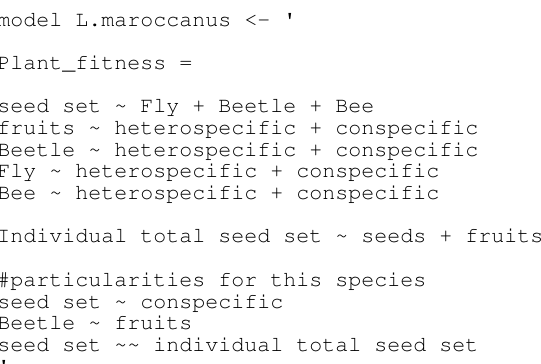
Figure 4. SEM of P. paludosa . As the ANOVA results and the AIC test suggest for this species, the unconstrained model fits the data better, and hence the scale is not considered. The lines (dashed and solid lines) are proportional to the magnitude of the relationships (we plot the standardized total effects) to exemplify the path. The numbers included on the paths are the standardized total effects, which remain the same across scales. The dashed lines represent negative relationships. It is important to mention that the correla- tions between the variables are not visualized on the path, but in the SEM they are included (Eq. A3, Appendix A) ( p value = 0.187; df = 95; R 2 of individual total seed set =∼